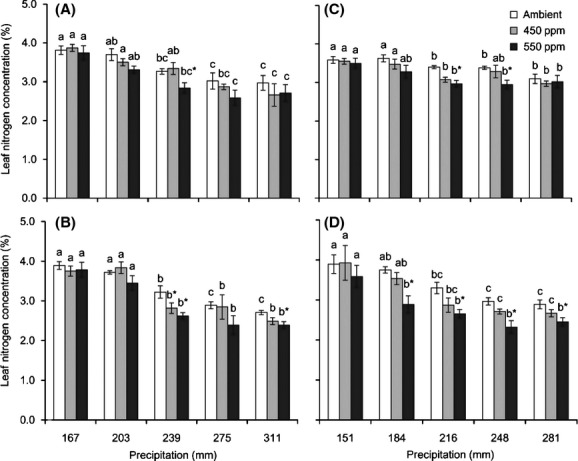
Interactive effects of changing precipitation and CO2 on the Nmass of four Stipa species: S. baicalensis (A), S. bungeana (B), S. grandis (C), and S. breviflora (D). Different lower case letters indicate significant differences among precipitation treatments for the same CO2 concentration (P < 0.05); * indicates significant differences between CO2 concentrations for the same level of precipitation (P < 0.05).